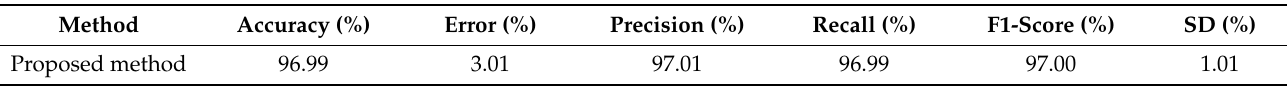
Table 7. Performance comparison in the recognition of signed-words (72 words, including single and double-hand ASL